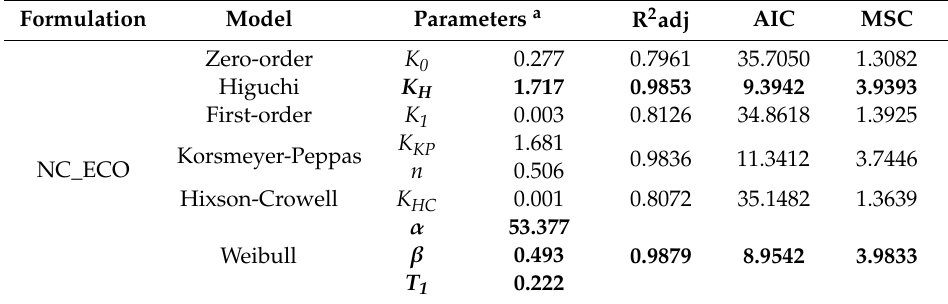
Table 3. Kinetic parameters obtained after fitting the release data from the NC_ECO to di ff erent release